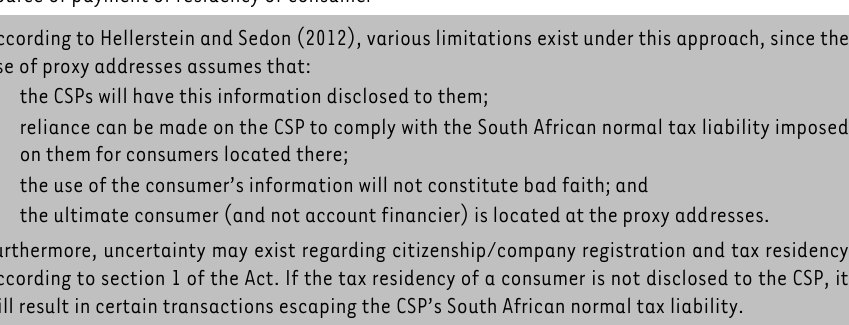
TABLE 2: Issues identified relating to source determination of service income The physical location of the